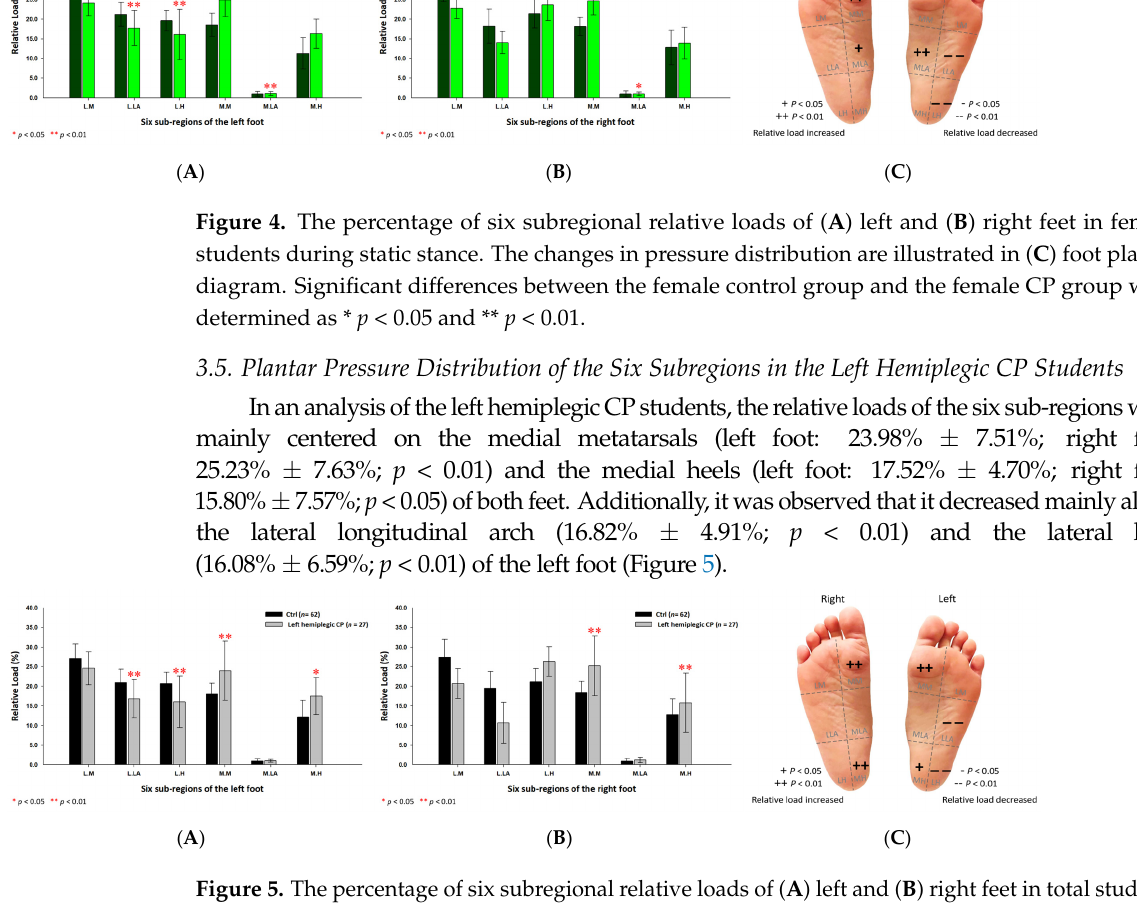
Figure 3. The percentage of six subregional relative loads of ( A ) left and ( B ) right feet in male students during static stance. The changes in pressure distribution are illustrated in ( C ) foot plantar diagram. Significant differences between the male control group and the male CP group were determined as * p < 0.05 and ** p < 0.01. As for the female CP group, the six subregional relative loads were mostly concen- trated at the medial metatarsal (24.70% ±3.60%; p < 0.01) of the right foot and the medial longitudinal arches (left foot: 1.04% ± 0.44%; right foot: 0.96% ± 0.48%; p < 0.05) of both feet, whereas, the relative loads were decreased at the lateral longitudinal arch (17.71% ± 4.51%; p < 0.01) and the lateral heel (16.07% ± 6.45%; p < 0.01) of the left foot (Figure 4).